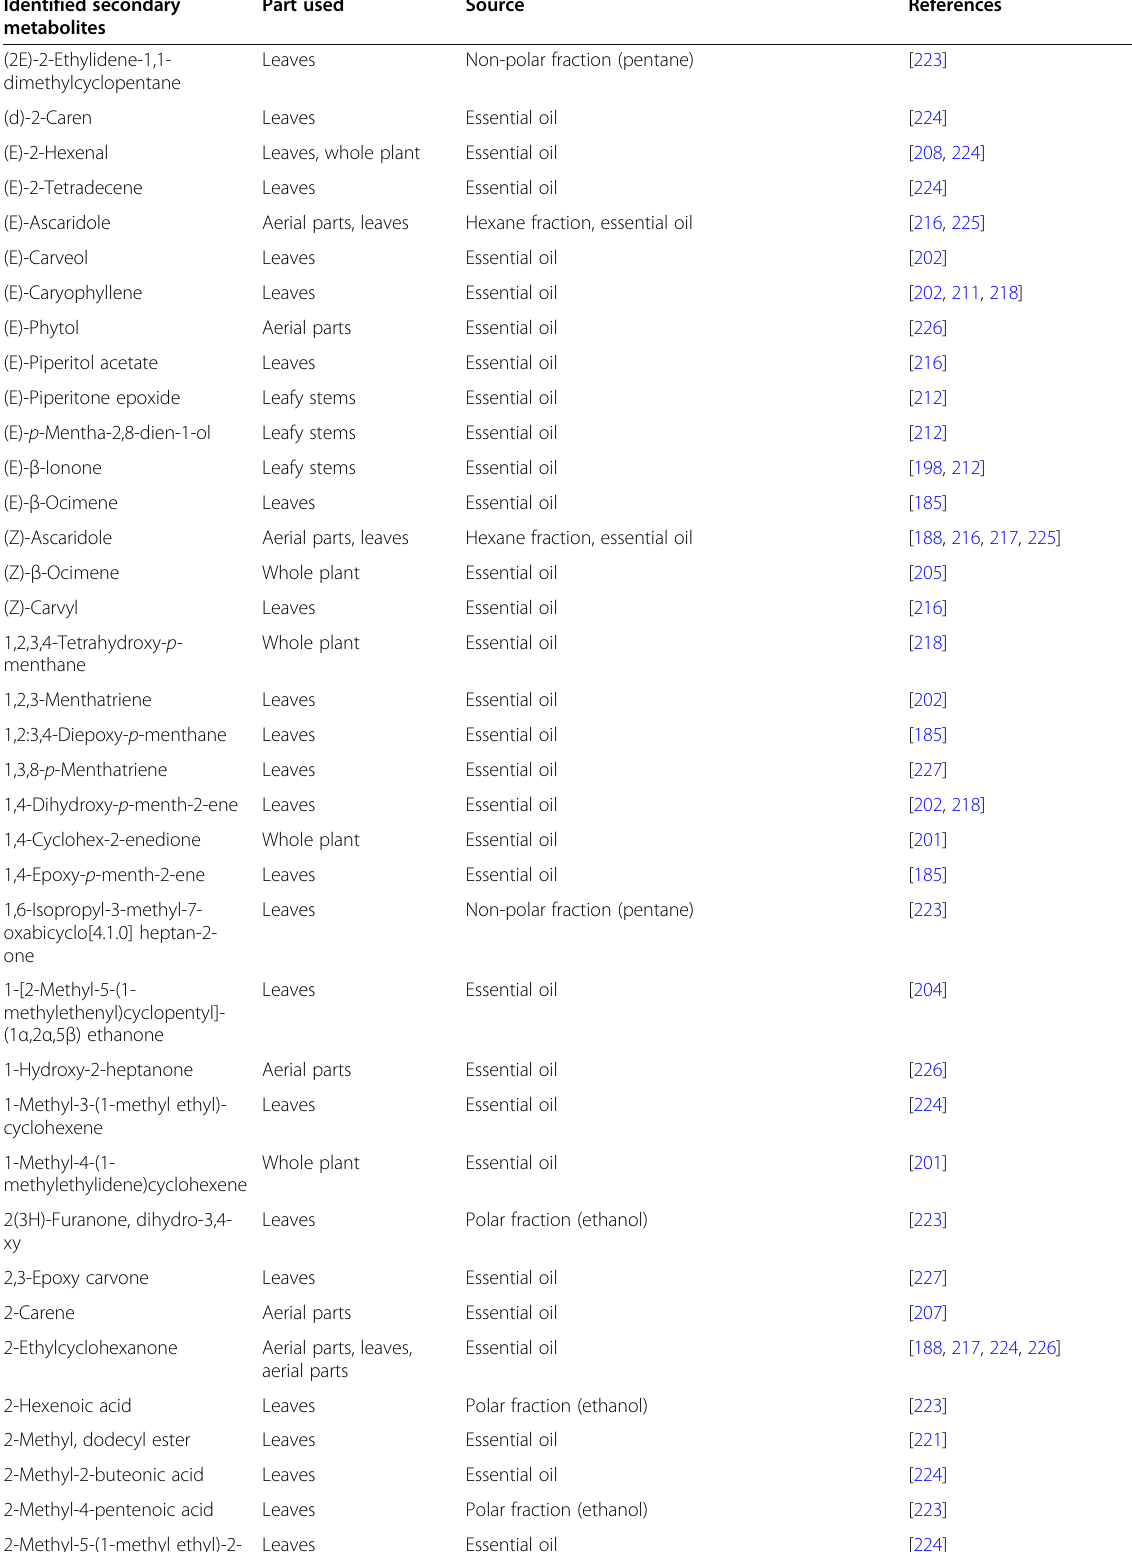
Table 3 Main secondary metabolites identified in C.